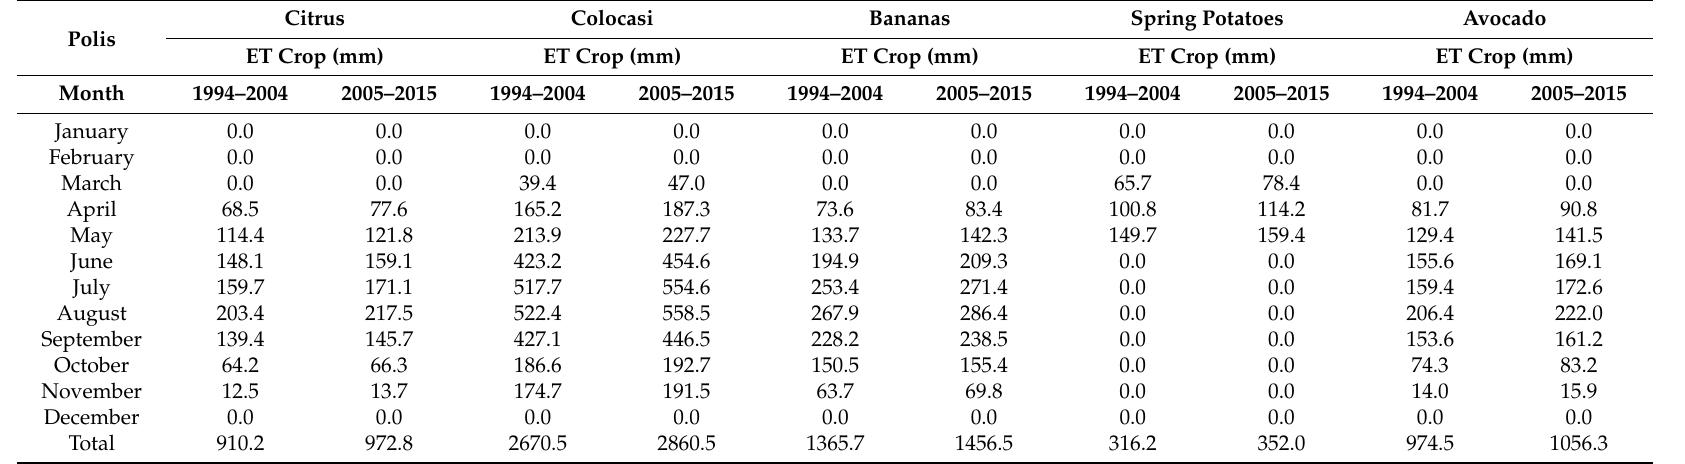
Table 3. Average monthly ETc values for each crop for the Polis